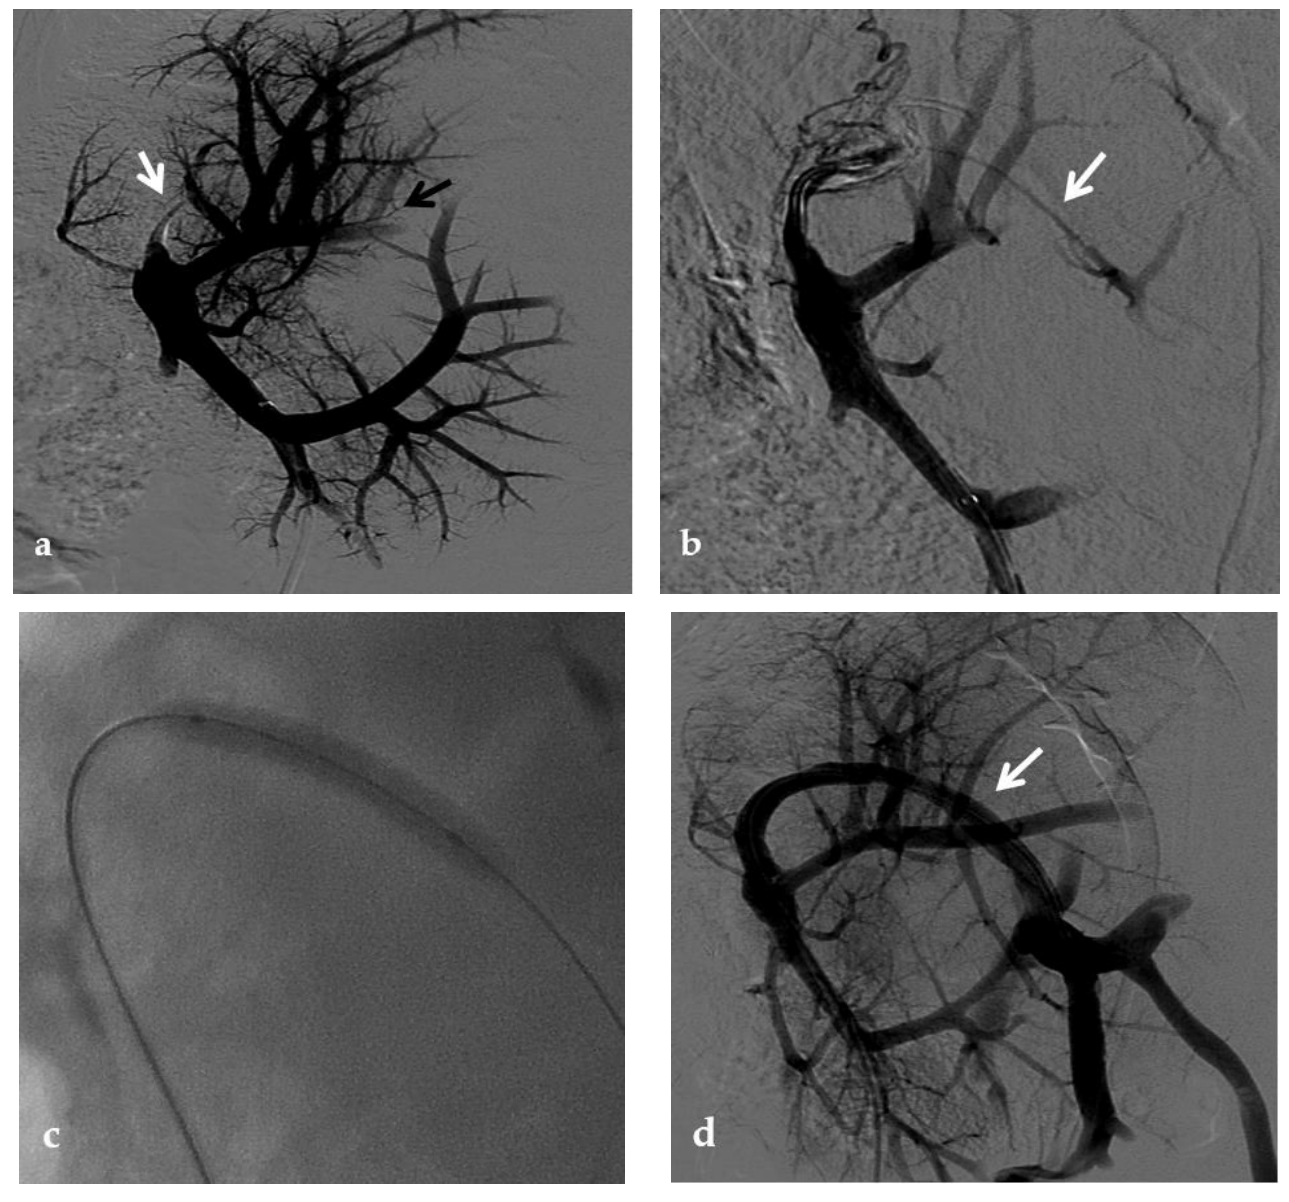
Figure 9. Anteroposterior view of a percutaneous transhepatic portography imaging series performed for chronic complete portal vein thrombosis with cavernous transformation in an 11-year-old boy with a history of gastrointestinal bleeding and portal hypertension 10 years after deceased-donor orthotopic liver transplantation (split II–III) for biliary atresia. ( a ) Portography image shows a regular representation of the segment 3 portal branch, while the segment 2 portal branch has a peripheral defect of opacification due to flow reversal, resulting from portal cavernoma and extrahepatic capsular feeding from gastric vessels (black arrow). Complete occlusion of the extrahepatic portal vein at the hepatic hilum (white arrow) is demonstrated. ( b ) Portography image shows the opacification of a very tiny vascular structure (arrow) which represents what remains of the thrombosed extrahepatic portal trunk. ( c ) Fluoroscopy image shows angioplasty with a non-compliant 8-mm balloon catheter performed on a stiff guidewire which was advanced across the obstructed tract. ( d ) Control portography shows a re-expanded extrahepatic portal vein (arrow) with normal spleno-portal opacification. Portal vein thrombosis recurred one year after treatment and required repeated angioplasty and metal stenting (shown in the next figure).